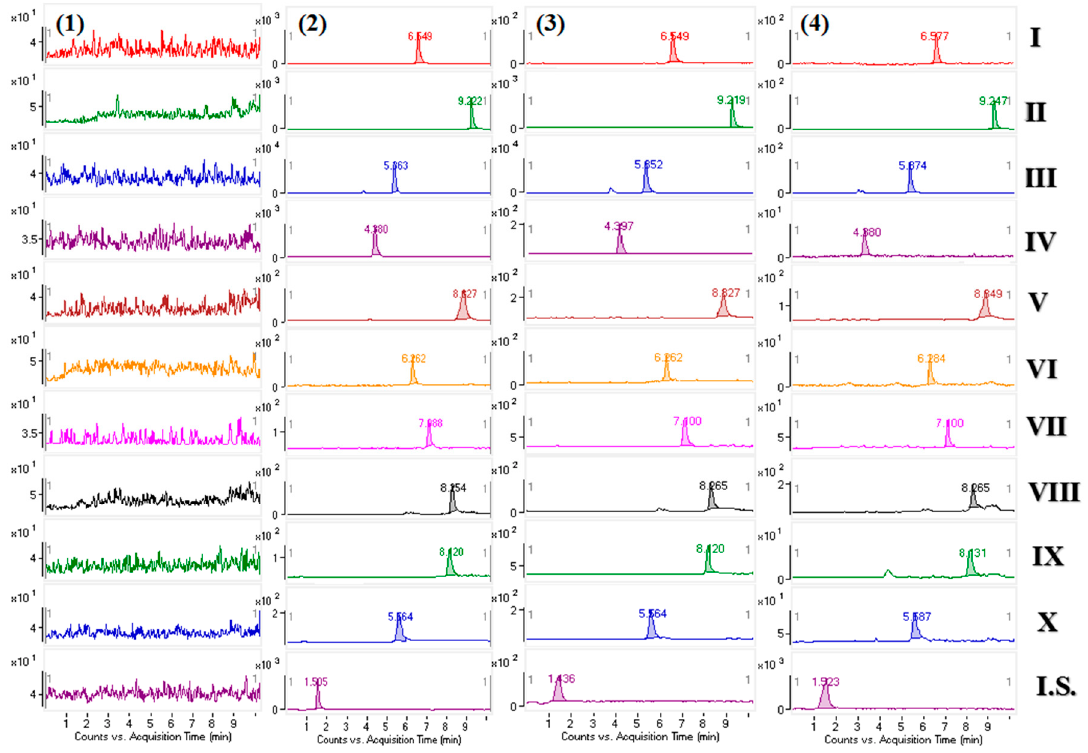
Figure 2. Representative MRM chromatograms of corydaline ( I ), dehydrocorydaline ( II ), tetrahydropalmatine ( III ), protopine ( IV ), palmatine ( V ), tetrahydroberberine ( VI ), columbamine ( VII ), berberine ( VIII ), berberrubine ( IX ), coptisine ( X ) and theophyline ( I.S. ) in the beagle dog plasma: ( 1 ) drug-free beagle dog plasma sample; ( 2 ) A beagle dog plasma sample taken 0.75 h after administration of 0.150 g/kg Yuanhuzhitong Tablets; ( 3 ) A beagle dog plasma sample taken 0.75 h after administration of 0.048 g/kg C. yanhusuo extraction; ( 4 ) LLOQ sample (10 alkaloids and I.S. in blank plasma).